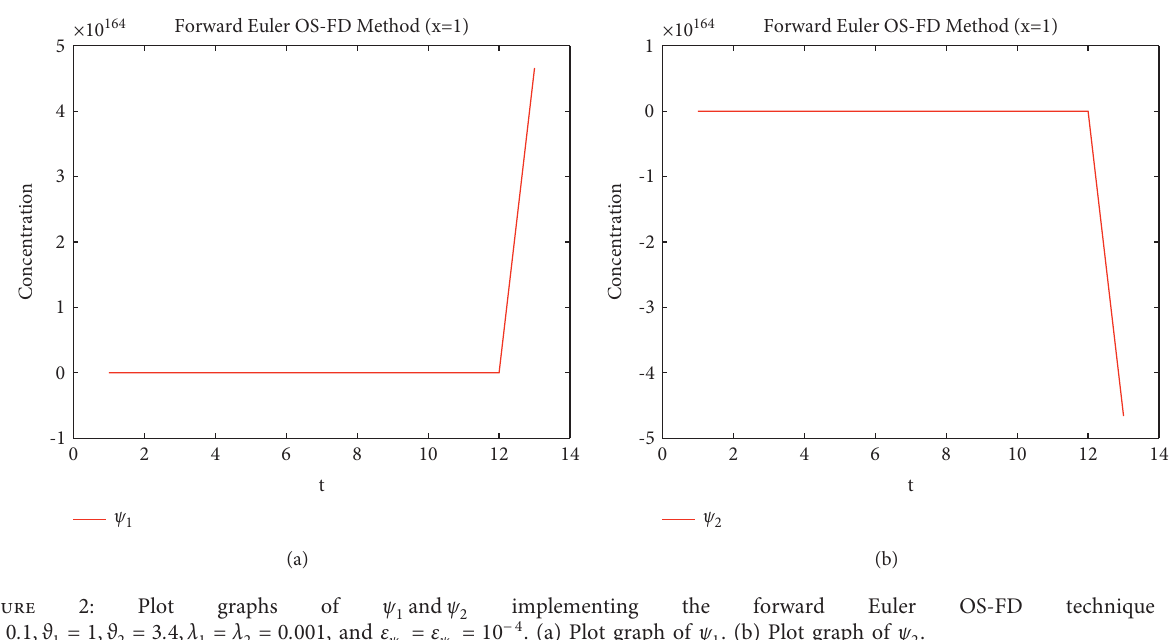
and ψ implementing the forward Euler OS-FD technique 1 2